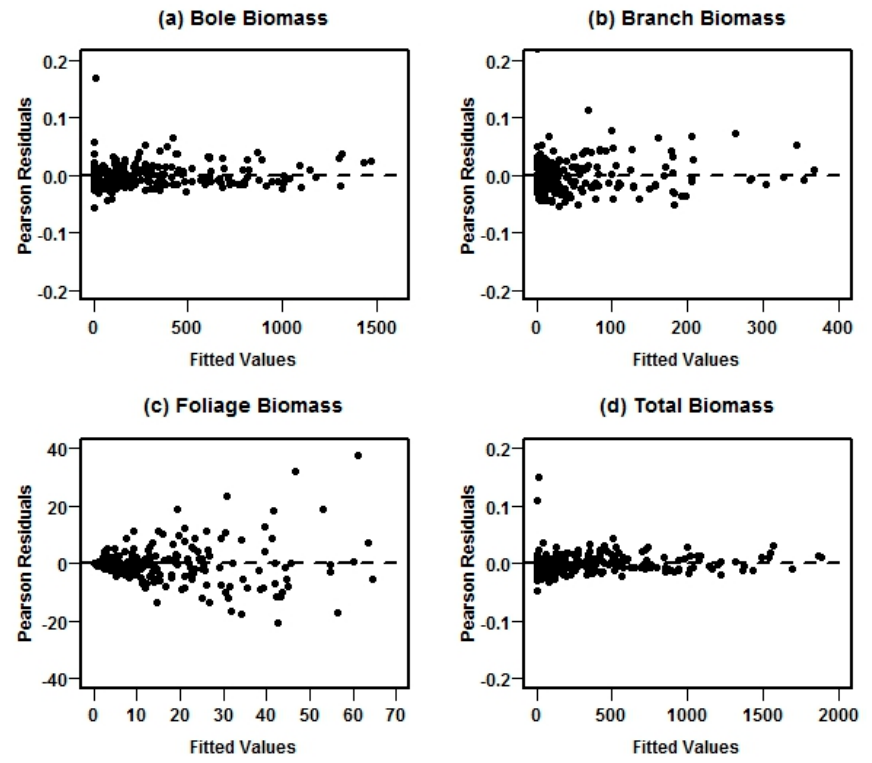
Figure 4. Pearson residual plots for each biomass component in the model system II fitted using NSUR method and different weight functions for each system equation with its own weight function. Table 3. Parameter estimates and their asymptotic standard error and p- values for the additive biomass equation system based on diameter at breast height (DBH) only (Model System I).